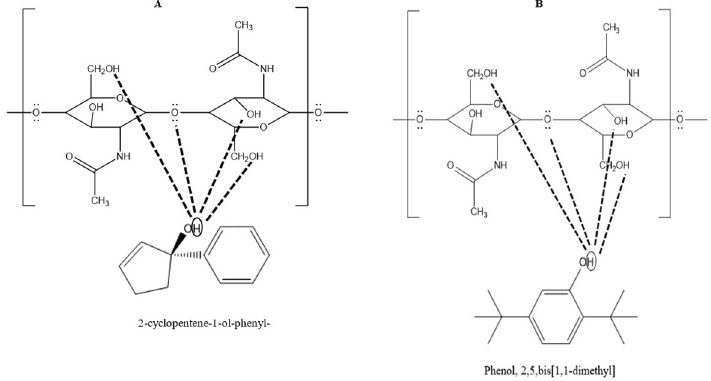
Fig 2. (A) Interaction of hydrogen of 2-cyclopentene-1-ol-phenyl- with oxygen and hydroxyl group present in chitin. (B) Interaction of hydrogen of Phenol,2, 5, bis [1,1-dimethyl] with oxygen and hydroxyl group present in chitin.